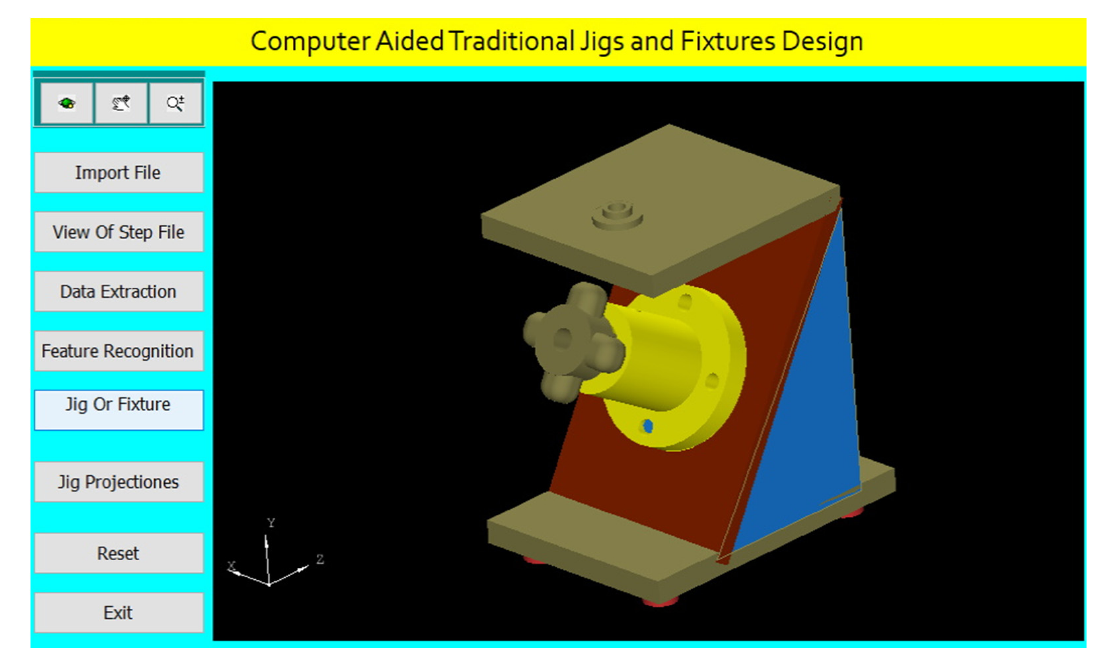
Figure 32. Computer-aided design of a jig for the cylindrical part.